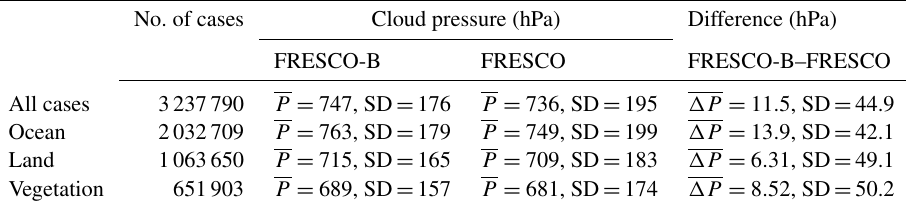
Table 4. Mean cloud pressures and standard deviations for FRESCO-B and FRESCO, as well as the mean difference between FRESCO-B and FRESCO, for GOME-2B measurements in July 2014 over different surfaces. The vegetation category is a subpart of the land